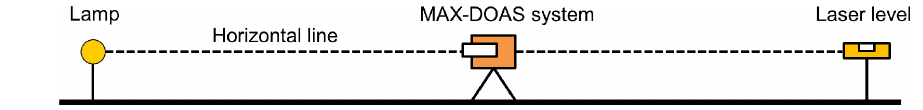
Figure 6. Sketch of the measurement setup for the near-lamp measurements and the alignment of telescope and lamp.